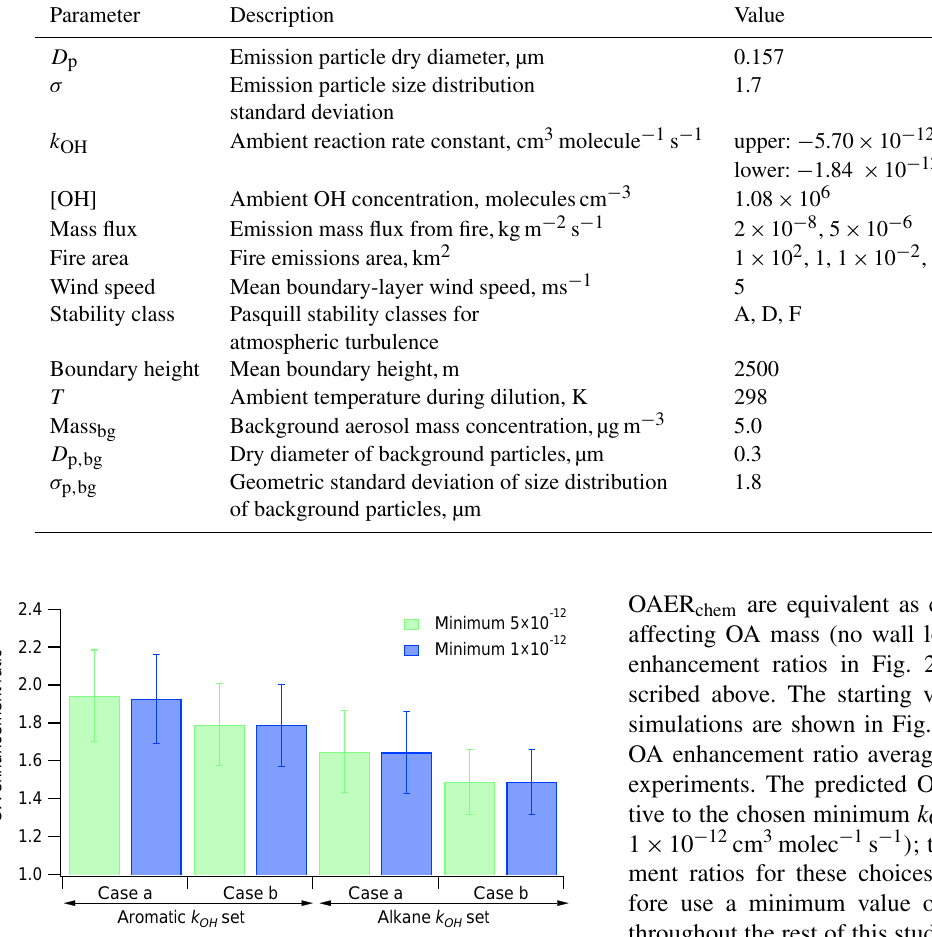
Figure 2. OA enhancement ratios (OAER inert and OAER chem are equivalent in these simulations), in the absence of particle and vapor wall losses, averaged over the 18 experimental simulations using k OH sets fitted for aromatics and alkanes with a four-volatility-bin drop per reaction (Case a) and a two-volatility-bin drop per reaction (Case b). The minimum k OH value is set to be 5 × 10 − 12 (green bars) and 1 × 10 − 12 (blue bars) cm 3 mole − 1 s − 1 , respectively. The error bars represent 1 standard deviation across the 18 simulations and represent experiment-to-experiment